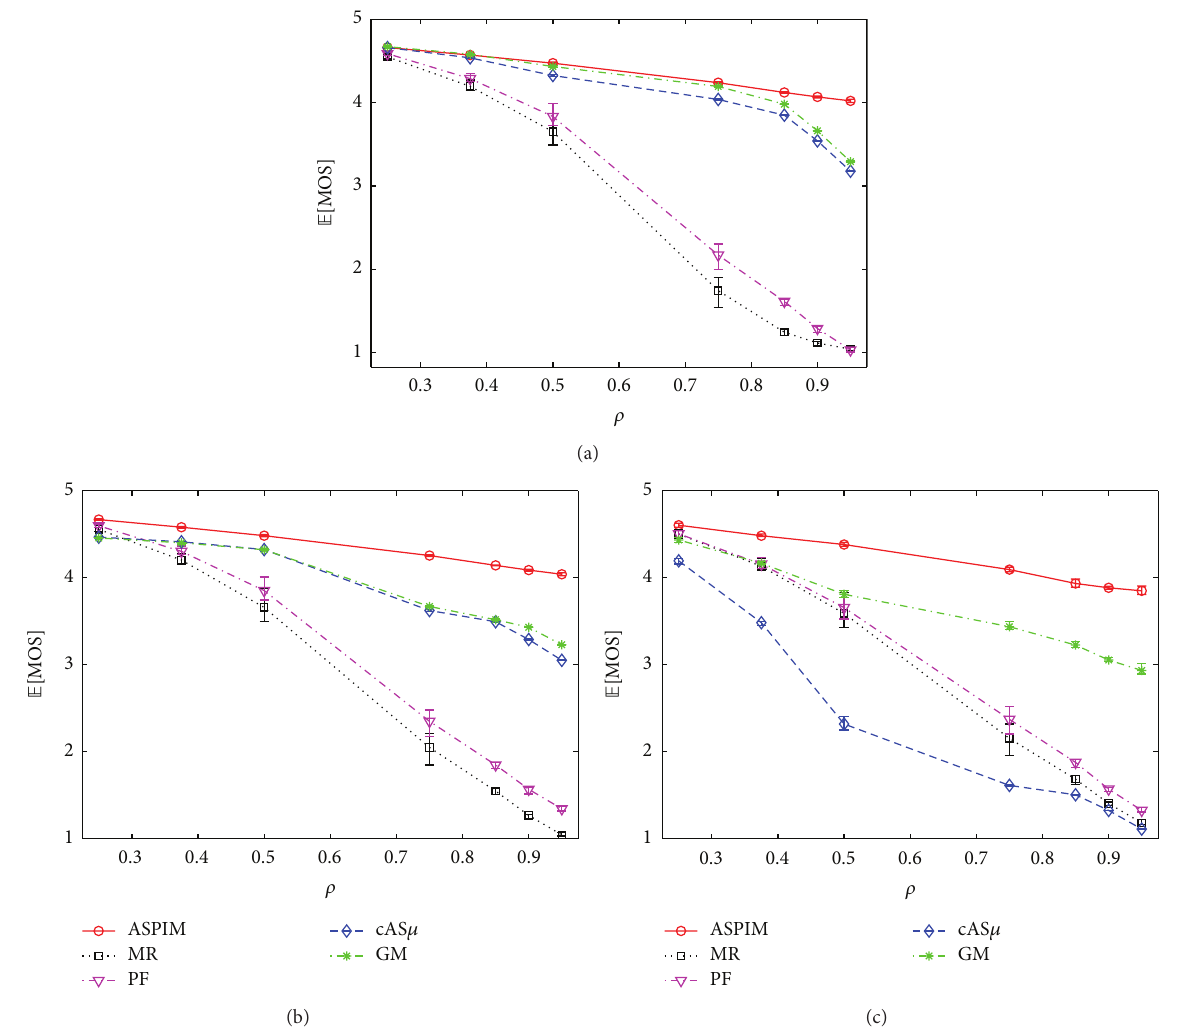
Figure 10: E [ MOS ] for 4G scenario: aggregate (a), class 1 (b), class 2